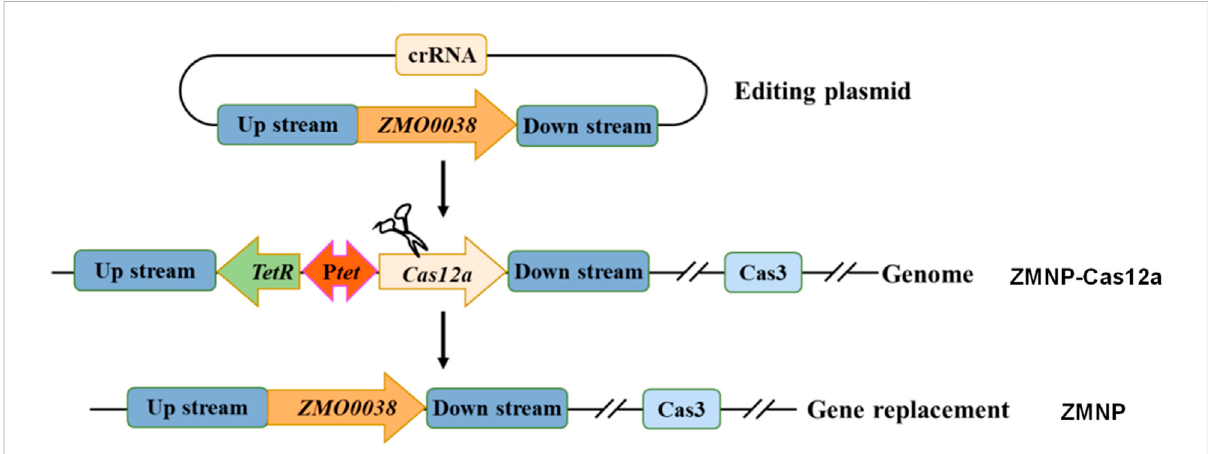
FIGURE 1 The scheme of ZMNP mutant construction by replacing cassette TetR-P tet - cas12a with ZMO0038 in Z. mobilis ZMNP-Cas12a using the native type I-F CRISPR system.